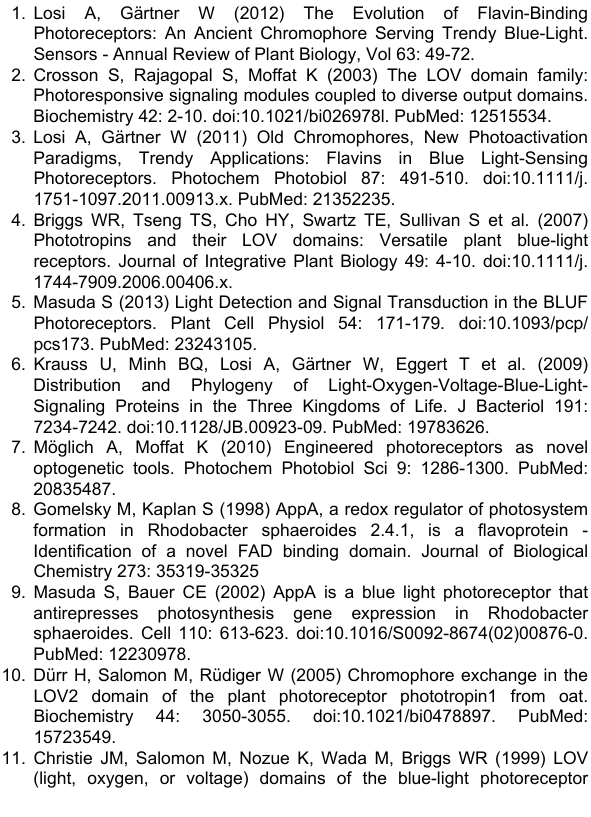
Chemical shifts of YLOV reconstituted